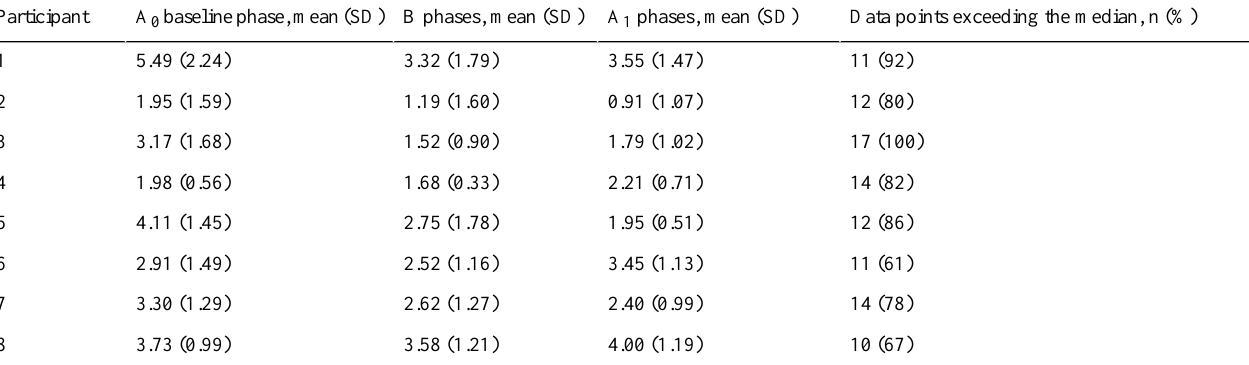
Table 3. Means and standard deviations of anxiety by phase and percentage of data points exceeding the median scores for each